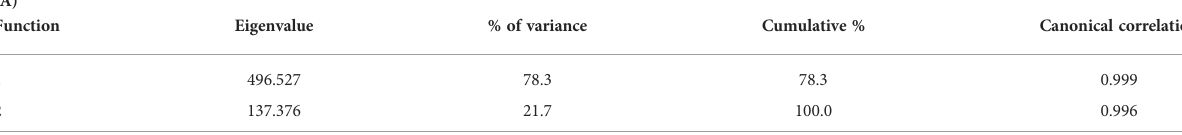
TABLE 1 (A) Summary of the canonical discrimination analysis for discriminant functions used to identi fi ed differences in digestive biochemistry among Seriola dumerili juveniles reared at different temperatures. (B) Standardized function coef fi cients for each of the signi fi cant discriminant functions used to identify differences in digestive